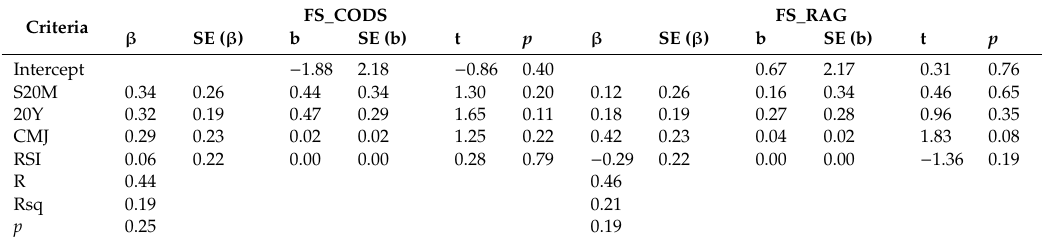
Table 5. Multiple regression calculation for the football specific change of direction speed, and football specific reactive agility (Criteria) among U13 players.